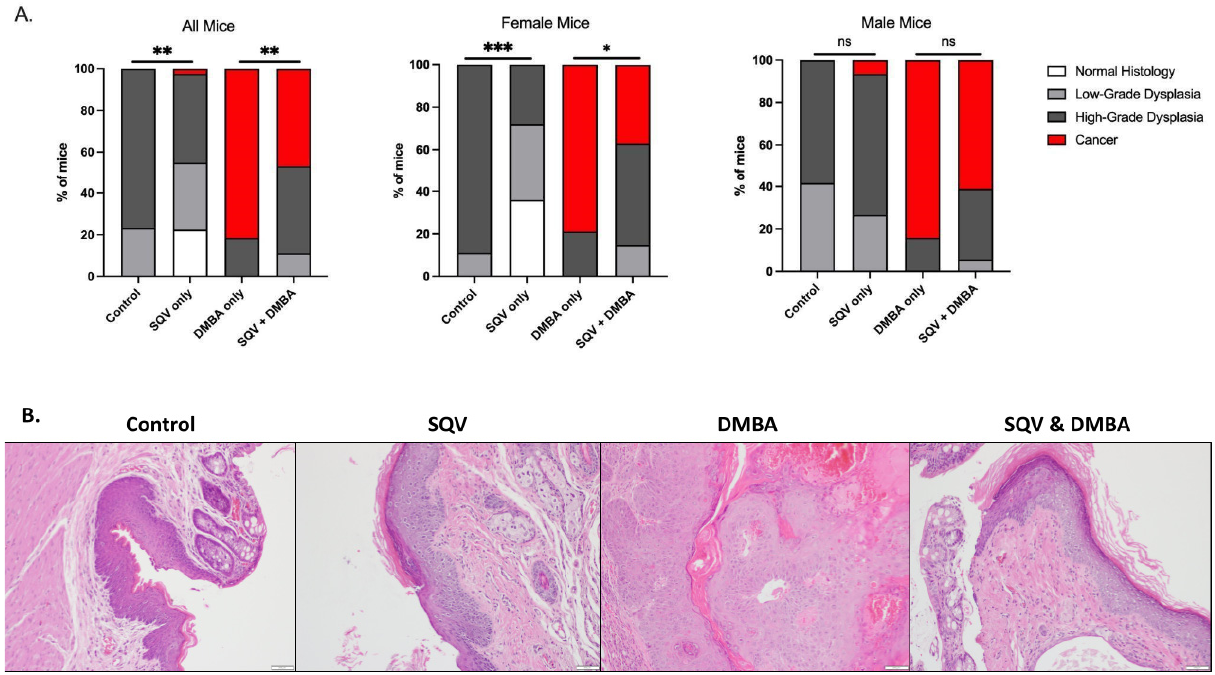
Figure 3. Final anal-tissue histology for mice in each treatment group: ( A ) All mice anal histology (combined female and male mice), female mice only anal histology, and male mice only anal histology. ( B ) Representative histological images per treatment group. Significance was assessed as * p < 0.05, ** p < 0.01, *** p < 0.001, “ns” is not significant.